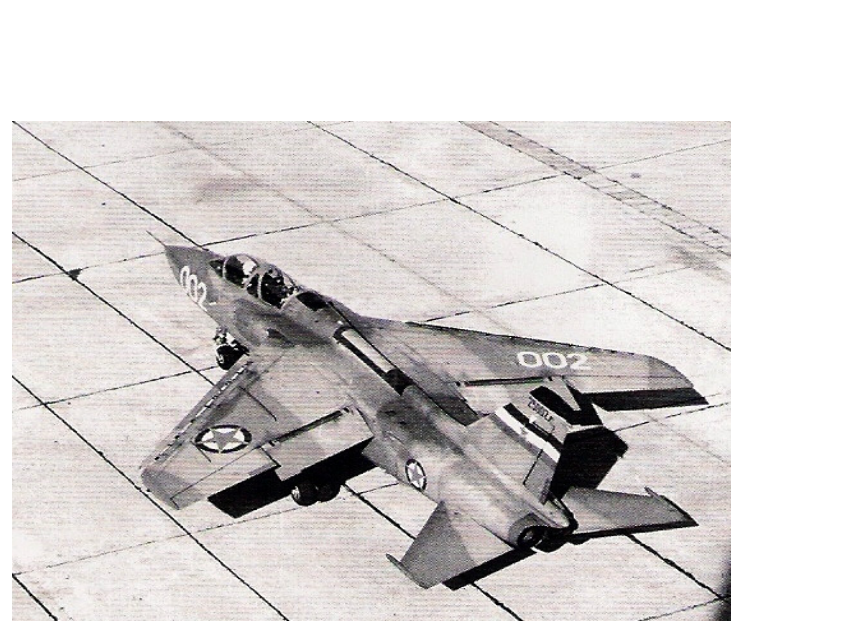
Figure 17 – Orao two-seater in which test pilot Branko Bilbija broke the sound barrier Рисунок 17 – Двухместный « Орел », на котором летчик - испытатель Бранко Билбия преодолел звуковой барьер